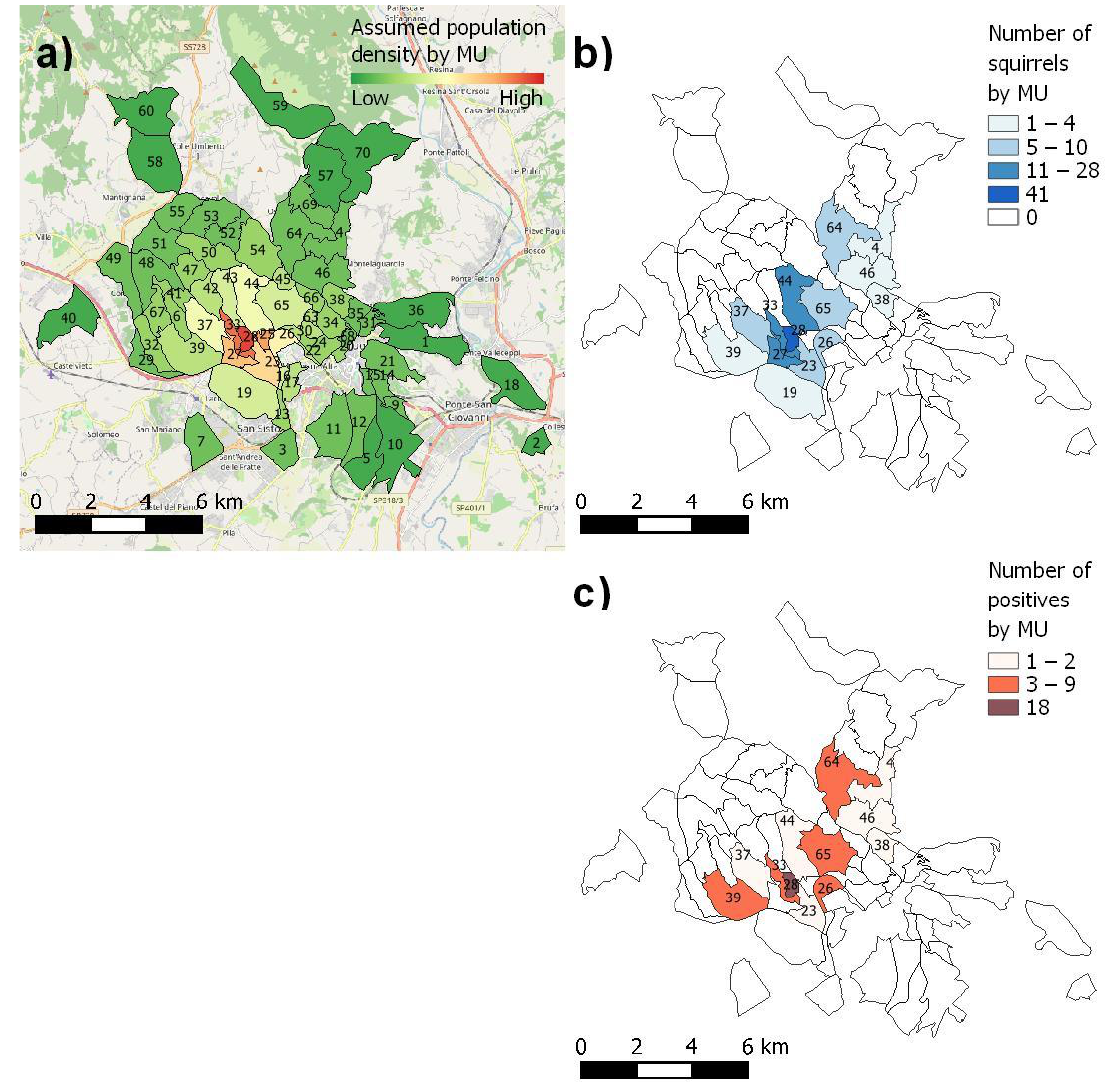
Figure 1. ( a ) Management units (MUs) and assumed grey squirrel population density moving away from the site of release, ( b ) number of squirrels by MU really submitted to health status evaluation, and ( c ) number of dermatophyte-positives squirrels by MU.